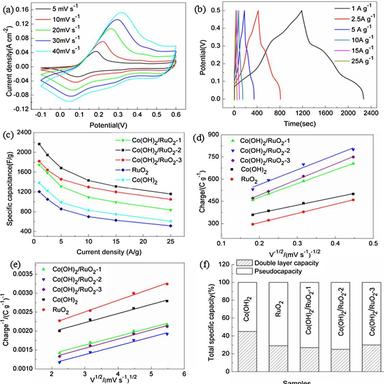
(a) CV curves of Co(OH)2/RuO2-2 under different scan rates; (b) GCD curves of Co(OH)2/RuO2-2 at various current densities; (c) variation in specific capacitance values of RuO2, Co(OH)2 and Co(OH)2/RuO2 nanocomposites at different current densities; (d) the relation of charge (Q) versus v−1/2; (e) the relation of Q−1 versus v1/2; (f) Contributions of double layer capacity and pseudocapacity to the total capacity of the RuO2、Co(OH)2 and Co(OH)2/RuO2 electrodes.